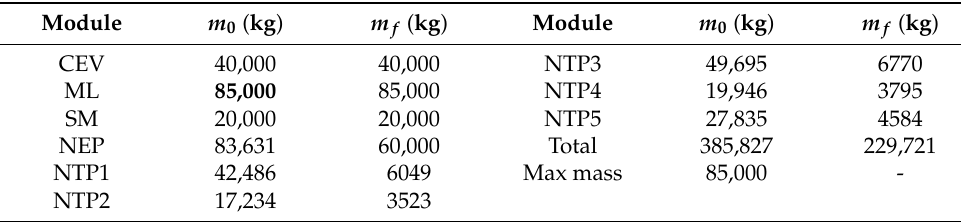
Table 20. Mass scale of Architecture-10.